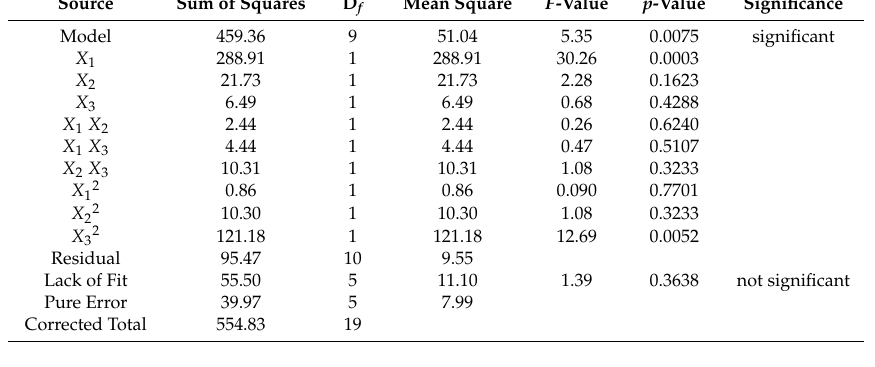
Table 2. ANOVA of response surface quadratic model.